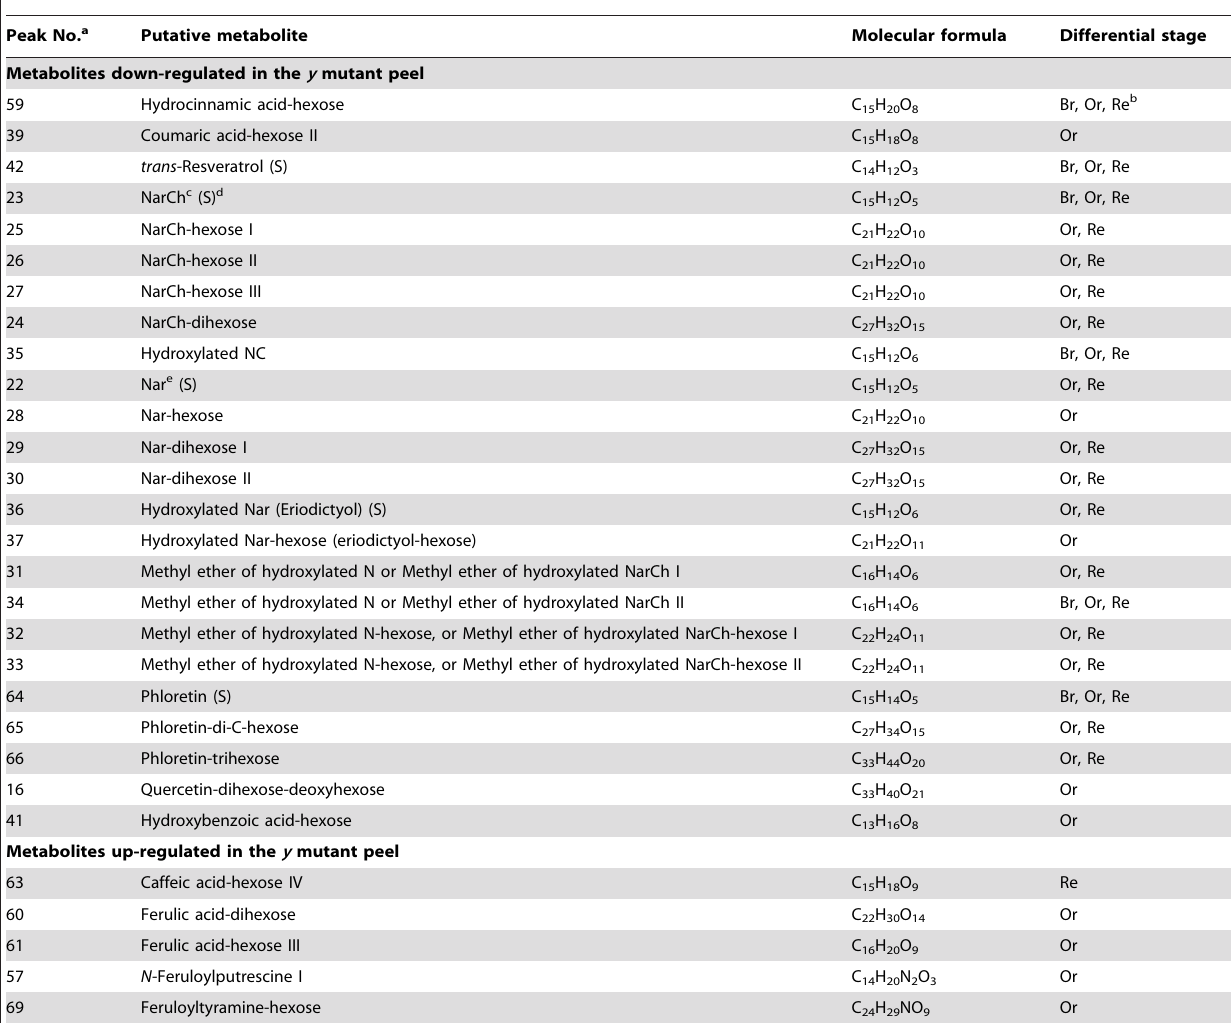
a The peak number here corresponds to the numbers given for all metabolites detected by the UPLC-QTOF-MS analysis in this study (see details in Table S2). b Br, Or and Re are for breaker, orange and red stages of fruit development,